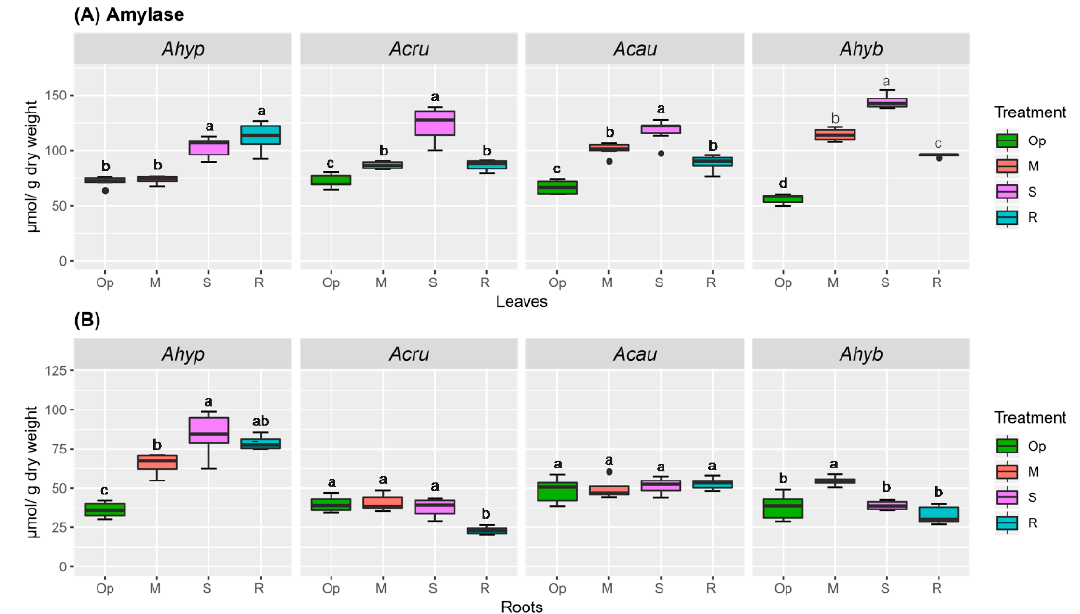
Figure 6. Amylase activity in amaranth plants subjected to water-deficit stress. Amylase activity